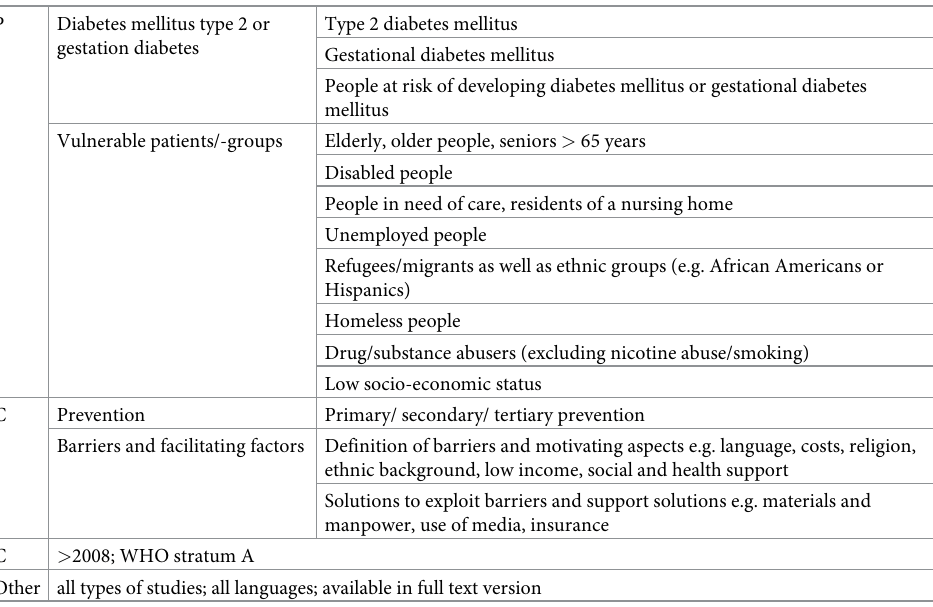
Table 1. PCC (Population, Concept,